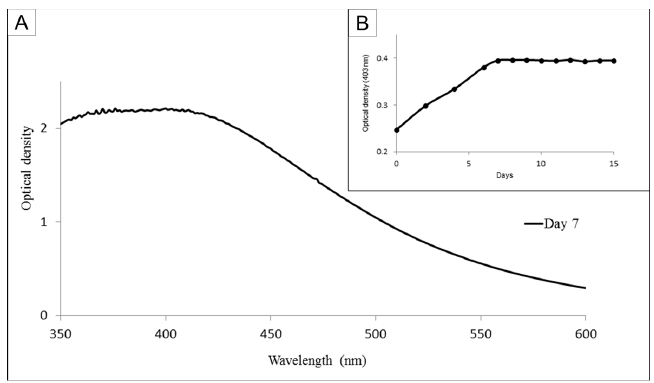
Figure 1. Light absorption profile of fucan-coated silver nanoparticles (FN) ( A ) Optical density in relation to the wavelength of 350 to 600 nm. ( B ) Optical density in light absorption ratio in 403 nm determined over 15 days.